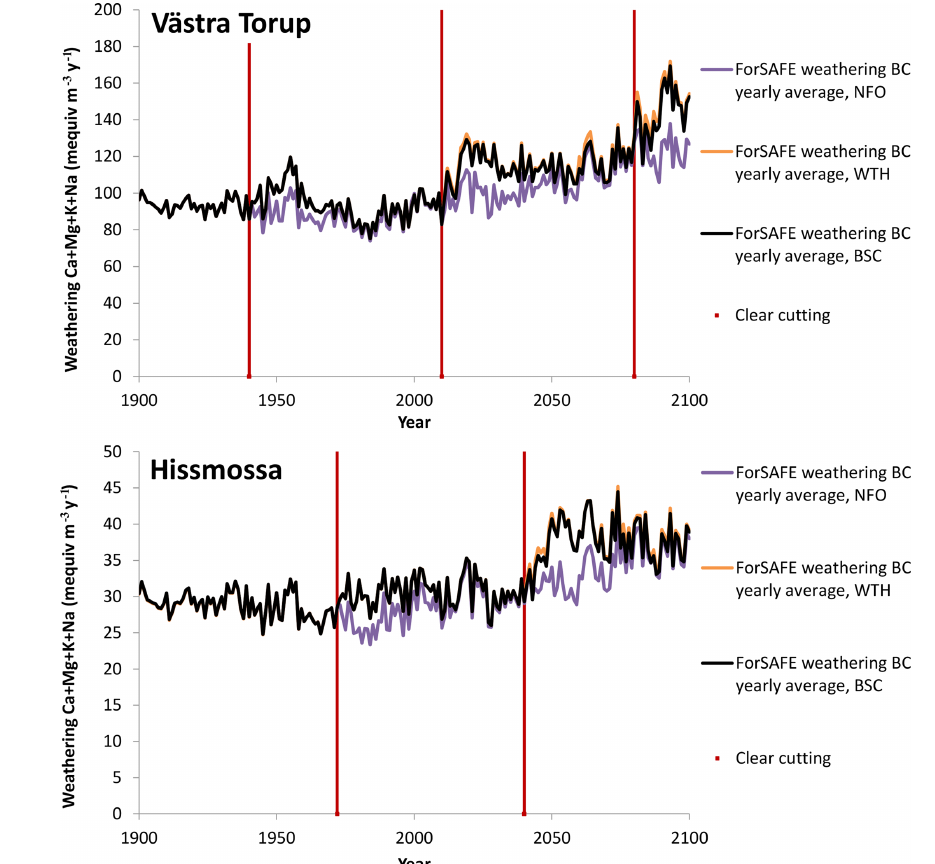
Figure 4. Yearly average weathering of base cations in the whole soil profile, for the BSC scenario, the whole-tree harvest WTH scenario, and the NFO scenario without any clear cutting or thinning. The years of clear cuts in the BSC and WTH scenarios are marked with vertical lines. In Västra Torup clear cuts are in the years 1940, 2010 and 2080 and in Hissmossa in 1972, 2040 and 2101.